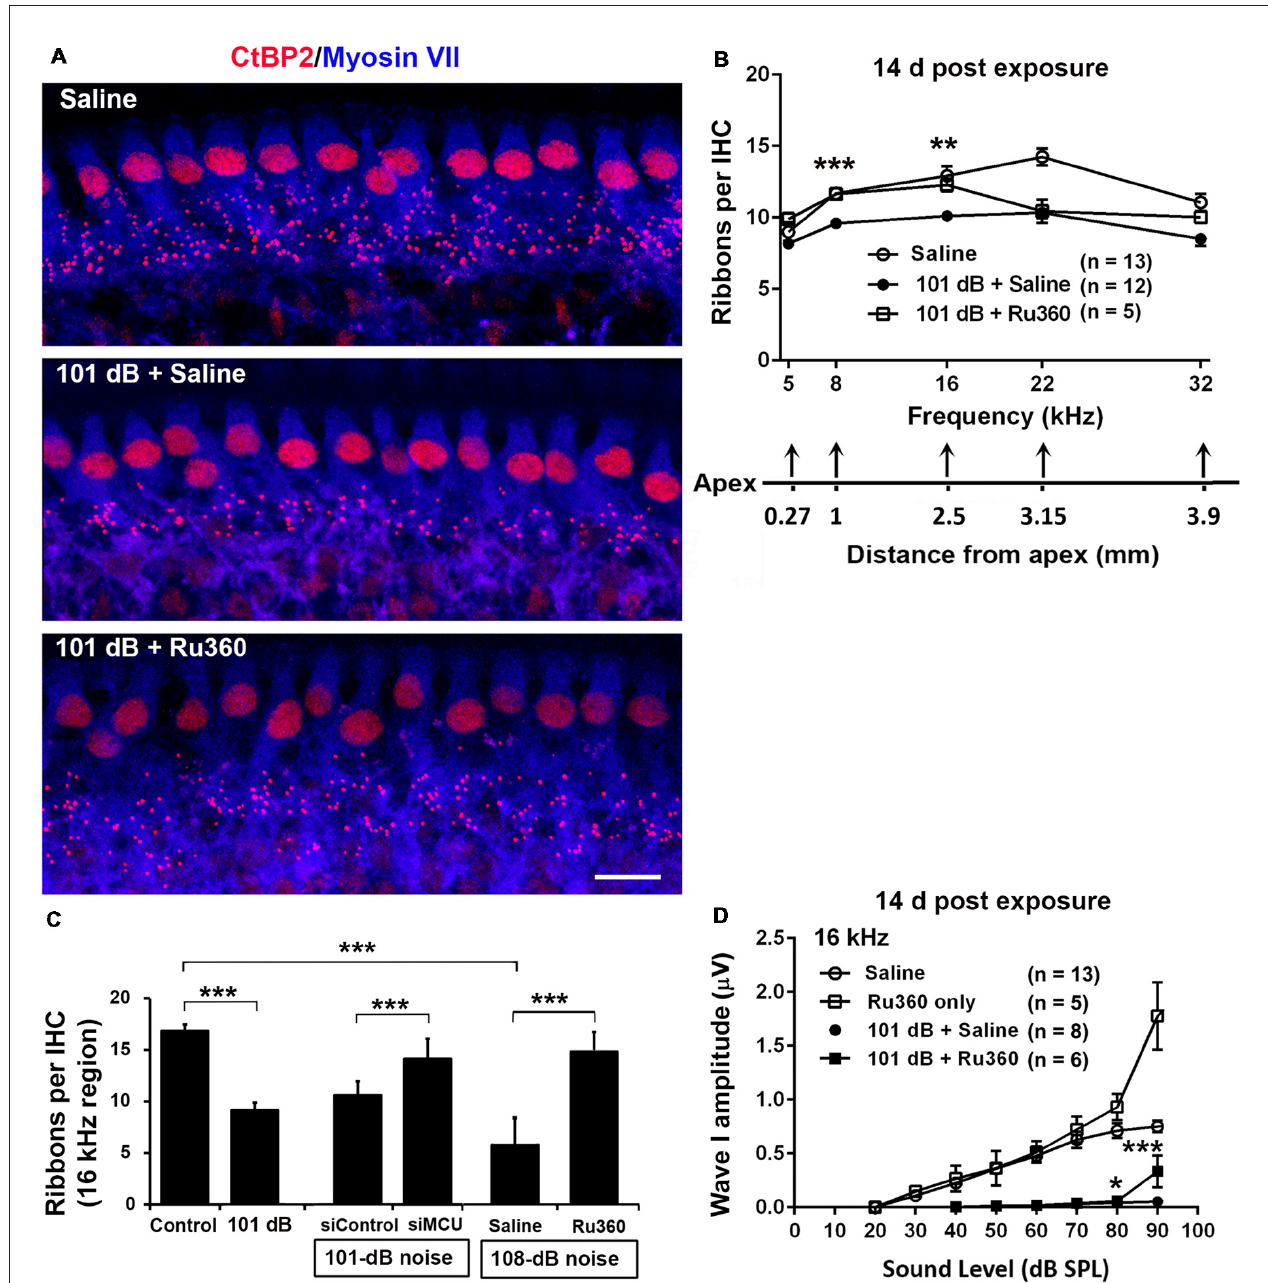
FIGURE 2 | Inhibition of MCU via Ru360 or siMCU attenuates noise-induced loss of synaptic ribbons and wave I amplitudes after the completion of noise exposure. (A) Representative images revealed immunolabeling for CtBP2 examined 14 days after noise exposure. Images are comprised of 40 Z-stack projections taken from the middle turn corresponding to sensitivity to 16 kHz. Blue: myosin-VIIa labeled IHCs, red: CtBP2-labeled synaptic ribbons and nuclei of IHCs; scale bar = 10 µ m. (B) Quantification of CtBP2-immunolabeled ribbon particles in IHCs corresponding to 5, 8, 16, 22, and 32 kHz showed significant reduction examined 14 days after noise exposure at all frequencies except 5 kHz (see Supplementary Table S1 for detailed statistical values). Treatment with Ru360 prevented noise-induced synaptic ribbon loss at 8 and 16 kHz. The distance along the cochlear duct correlating with the frequency regions is indicated. Data are presented as means + SEM. ∗∗ p < 0.01, ∗∗∗ p < 0.001 for 101 dB + Saline vs. 101 dB + Ru360. (C) CtBP2-immunolabeled ribbon particles in IHCs at 16 kHz region also decrease examined 1 h after noise exposure that partially prevented with siMCU pretreatment; n = 4 mice per group with one cochlea used per mouse. Treatment with Ru360 also attenuated higher intensity noise sound pressure level (108-dB-SPL)-induced synaptic ribbon loss; n = 6 mice per group with one cochlea used per mouse. Data are presented as means + SD. ∗∗∗ p < 0.001. (D) Ru360 treatment alone increased wave I amplitudes at sound intensities of 90 dB SPL. Noise-reduced wave I amplitudes at sound intensities of 80 and 90 dB SPL were rescued by treatment with Ru360. Data are presented as means + SEM, ∗ p < 0.05, ∗∗∗ p < 0.001 corresponds to 101 dB + Saline vs. 101 dB + Ru360. In panels (B,D) n indicates the number of mice per group; the left cochlea was used from each mouse for these experiments.